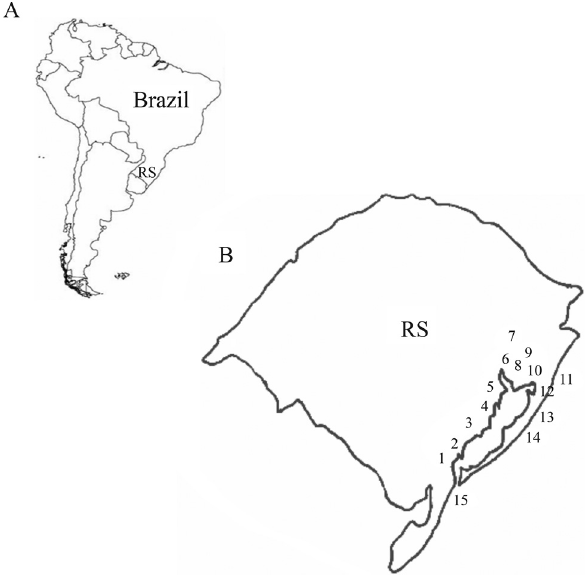
Figure 1 - Study area (RS: Rio Grande do Sul; PL: Patos lagoon). Popula- tions; PEL (1) (Pelotas); CZ3 (2) (Colônia Z3); SLS (3) (São Lourenço do Sul); TAP (4) (Tapes); BRI (5) (Barra do Ribeiro); ABE (6) (Águas Belas); CSU (7) (Caxias do Sul); POA (8) (Porto Alegre); MSA (9) (Morro Santana); GLO (10) (Glorinha); CID (11) (Cidreira); PAL (12) (Palmares do Sul);. MOS (13) (Mostardas); TAV (14) (Tavares); CAS (15)